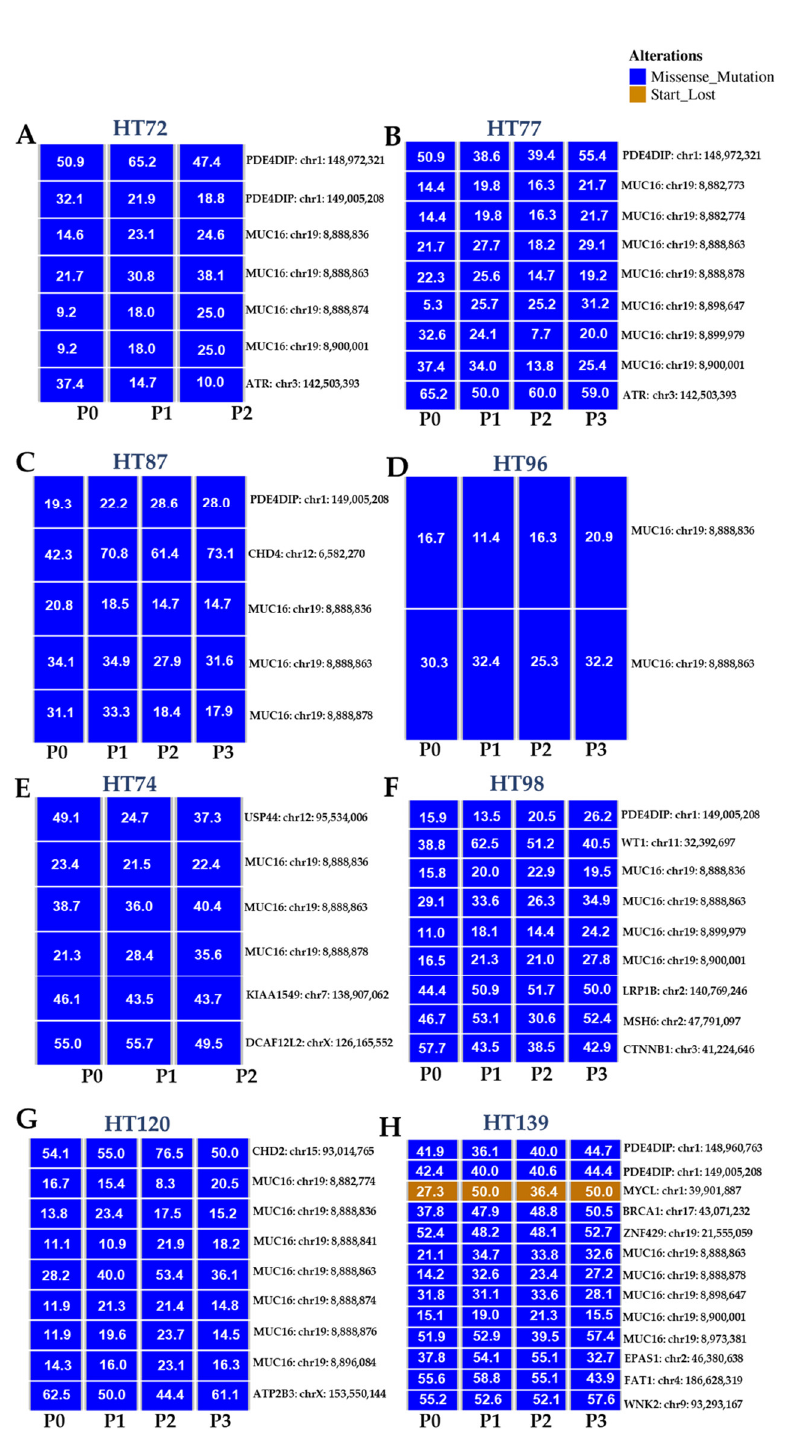
Figure 10. Identification of deleterious predictions of variant consequences in specific genes. SIFT and Polyphen algorithms were used to identify potential deleterious/damaging consequence of the variant on gene function. VAFs and oncoplots are presented for each variant when the frequency was ≥0.20 for at least one of the samples (P0 and/or its respective passaged PDXs). As previously mentioned, variants of high qualities (depth ≥ 10, genotype quality ≥ 20, allelic balance between 0.2–0.8) that are predicted to be of high impact and deleterious effect on functions (polyphen score > 0.15 and SIFT ≤ 0.05) were retained [41]. ( A ) HT72 (OS), ( B ) HT77 (OS), ( C ) HT87 (OS), ( D ) HT96 (OS), ( E ) HT74 (RMS), ( F ) HT98 (Wilms tumor), ( G ) HT120 (Wilms tumor), and ( H ) HT139 (Wilms tumor).